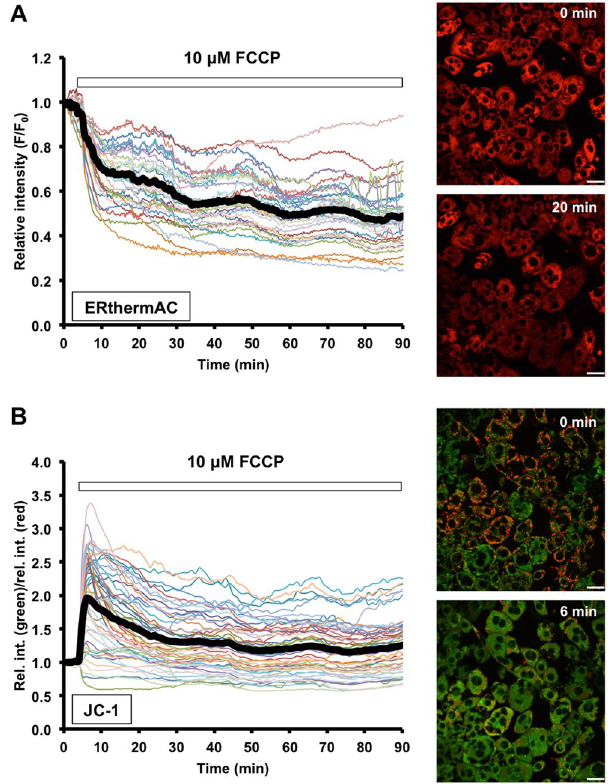
Figure 3. FCCP stimulation resulted in immediate effects in WT-1 cells. ( A ) ERthermAC intensity drastically decreases upon FCCP stimulation in all cells, without any lag phase, indicating increased intracellular temperature. The thick black curve corresponds to the mean relative intensity; n = 35 cells from 2 cultures. Scale bar: 20 μ m. ( B ) JC-1 staining shows immediate mitochondrial depolarisation after FCCP treatment. The thick black curve corresponds to the mean relative intensity ratio of green (JC-1 monomers) and red (JC-1 aggregates) signals; n = 50 cells from 2 cultures. Scale bar: 20 μ